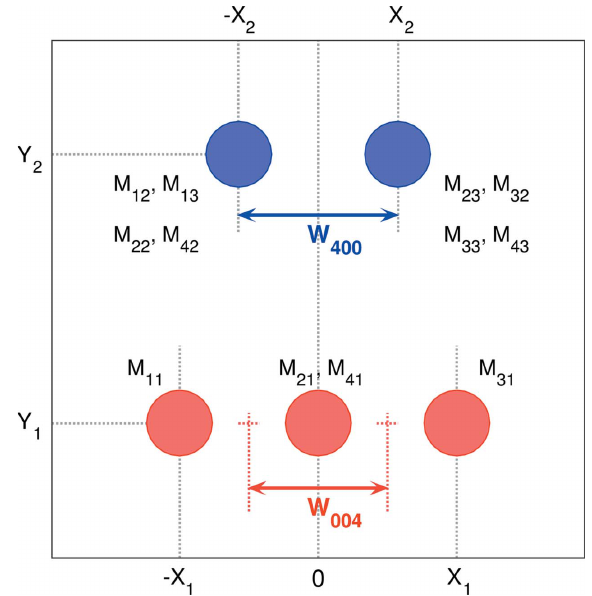
Figure 6 Schematic drawing for the set of {004} reflections, corresponding to 12 monoclinic domains. The positions of all peaks are described by four independent parameters, X 1 , Y 1 , X 2 and Y 2 (as used in Table 1), which are directly connected to the monoclinic distortion parameters (cid:3) c 1 , (cid:3) (cid:9) 1 , (cid:3) a 2 and (cid:3) 2 by equations (4) in the text. An animated version is available in the supporting